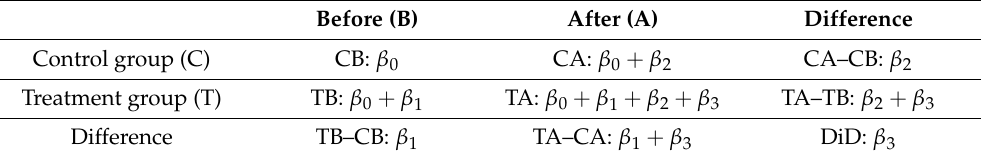
Table A1. Calculating the DiD